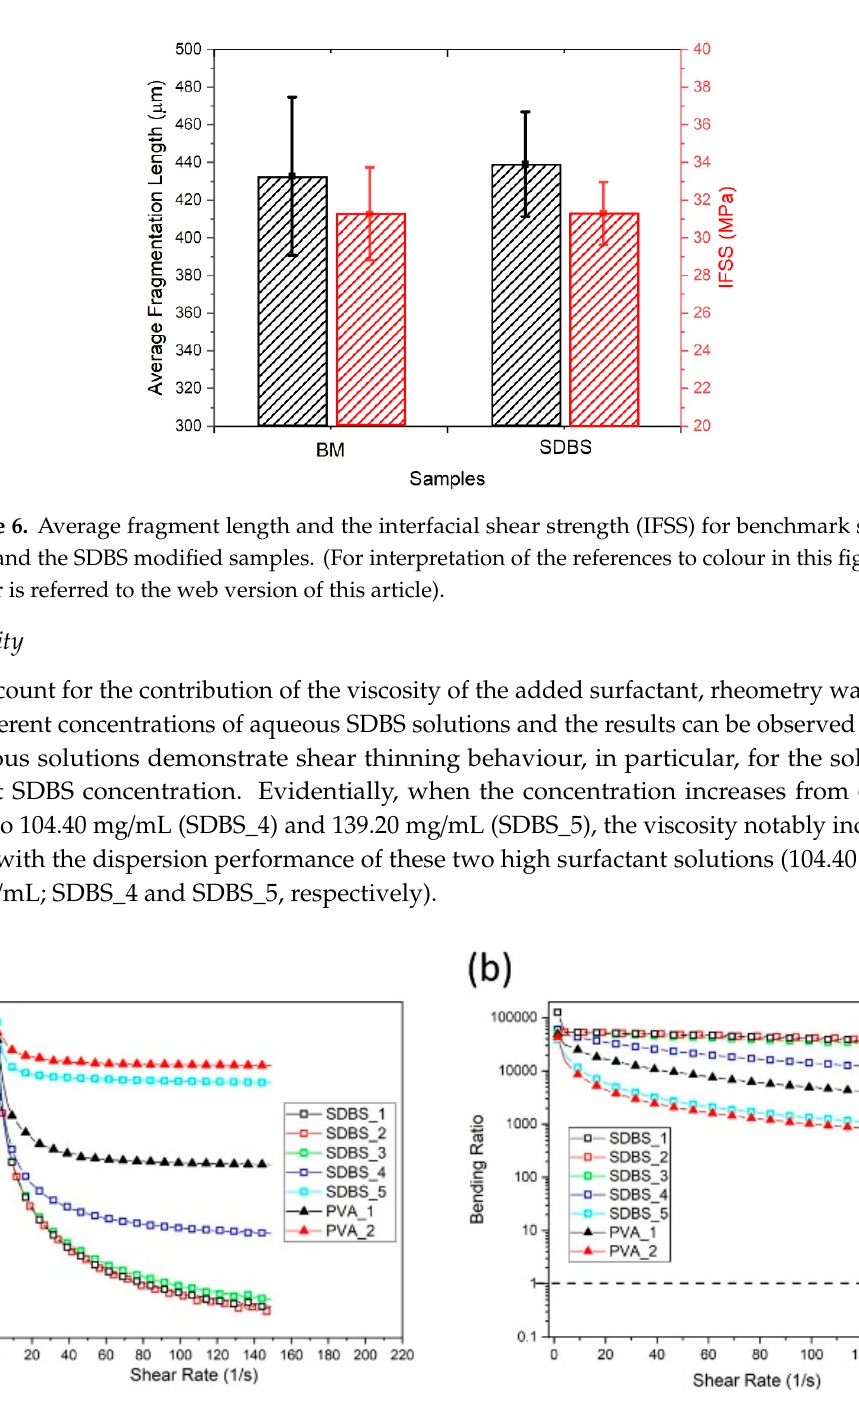
Figure 7. ( a ) The rheological response of the aqueous–SDBS solution. ( b ) The bending ratio with respect to shear rate for each of the aqueous solutions. The dashed line in ( b ) refers to the prediction of fibre bending. (For interpretation of the references to colour in this figure, the reader is referred to the web version of this article).